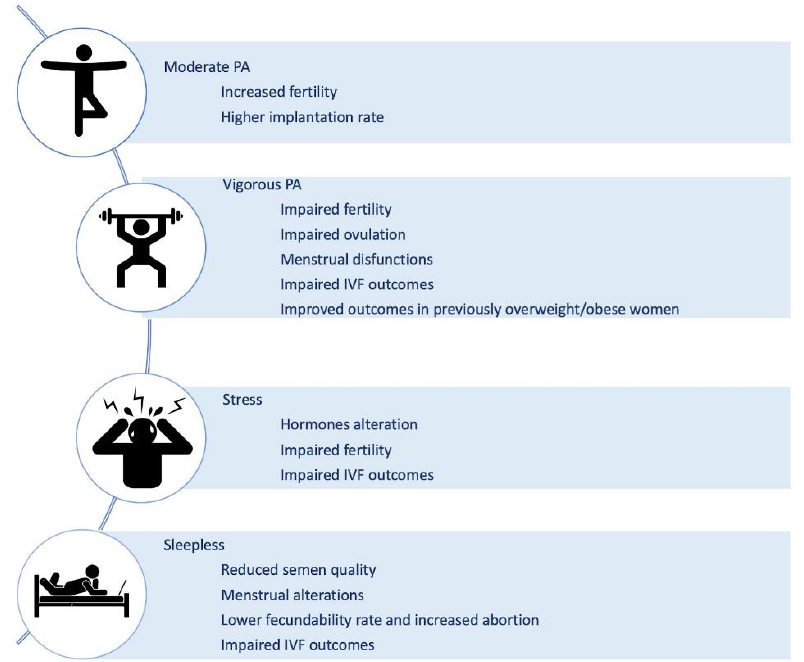
Figure 3. Lifestyle-related factors able to influence human reproduction. Physical activity (PA), stress and sleep have been related to different effects on both fertility and in vitro fertilization (IVF) procedure outcomes